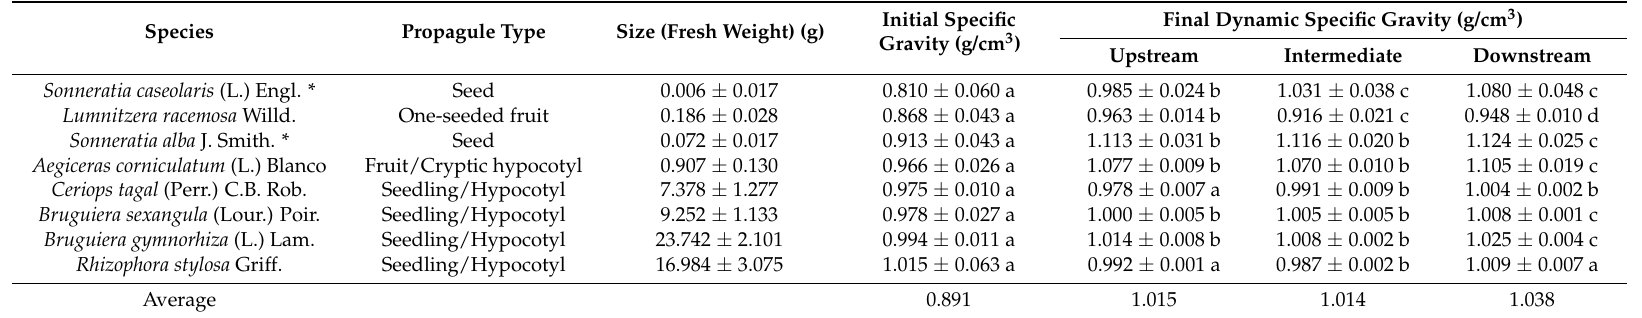
Table 1. Type, size, initial specific gravity, and final dynamic specific gravity of the propagules ( n = 20) of eight mangrove species after 20 days of floating along the Wenchang River, Hainan, China. Nomenclature follows Tomlinson [21]. Values are mean ± SE. Different letters after specific gravity data of the same species indicate significant differences at p <